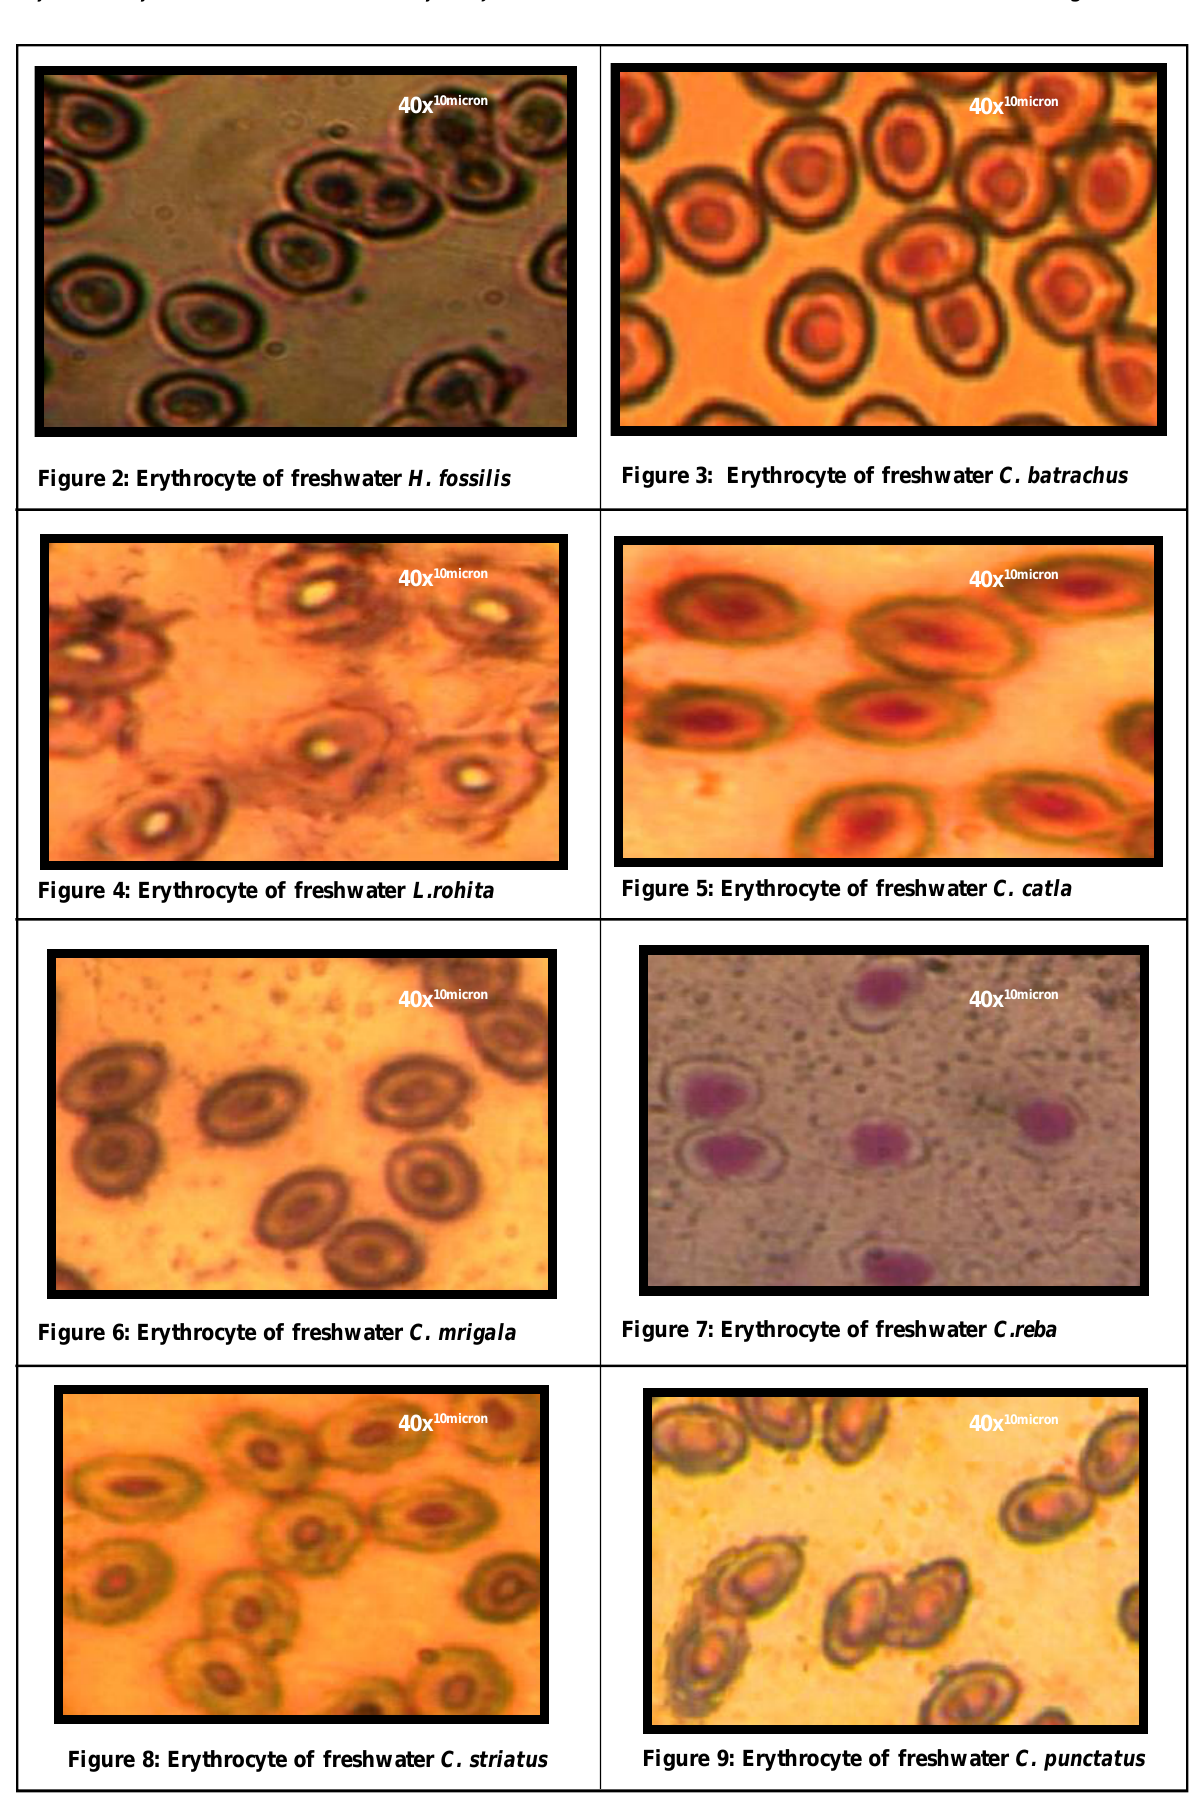
Figure 8: Erythrocyte of freshwater C. striatus Figure 9: Erythrocyte of freshwater C.